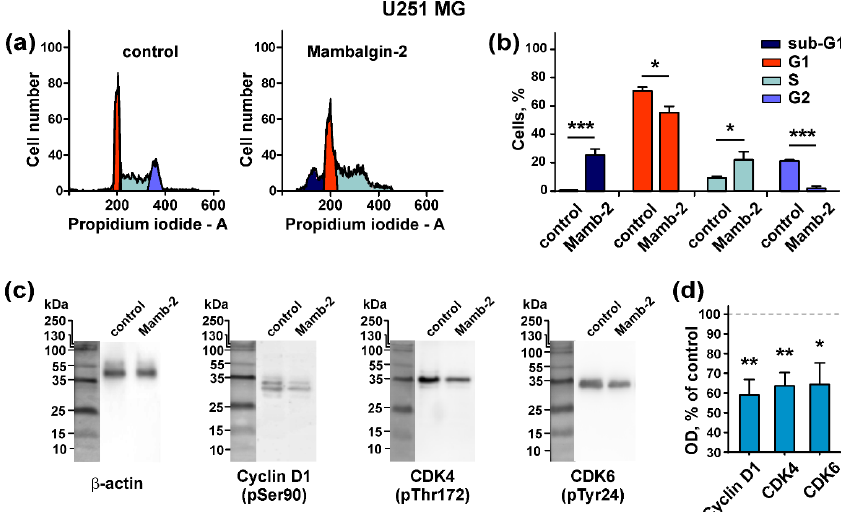
Figure 5. Mambalgin-2 influence on the cell cycle and activity of cell cycle regulators in U251 MG cells: ( a ) Representative nuclei population distributions of cells after 72-h incubation in absence (control) or presence of 1 µ M mambalgin-2; ( b ) % of cells in each cell cycle phase determined by ModFitLT Software. Data are presented as % of cells in each cell cycle phase ± SEM, n = 4; * ( p < 0.05) and *** ( p < 0.001) indicate the significant di ff erence from the control by two-tailed t -test; ( c ) Representative Western blots, showing the mambalgin-2 influence on phosphorylation of Cyclin D1 (pSer90), cyclin-dependent kinases (CDK)4 (pThr172), and CDK6 (pTyr24); ( d ) The optical density (OD) of blot bands for comparison of the Cyclin D1 (pSer90), CDK4 (pThr172), CDK6 (pTyr24) expression upon 72-h incubation of cells in absence (control) or presence of 1 µ M mambalgin-2. Data are presented as normalized to the β -actin band intensity, where untreated cells are taken as the control (100%, dashed line) ± SEM, n = 6; * ( p < 0.05) and ** ( p < 0.01) indicate the significant di ff erence between control and mambalgin-2 treated cells by two-tailed t